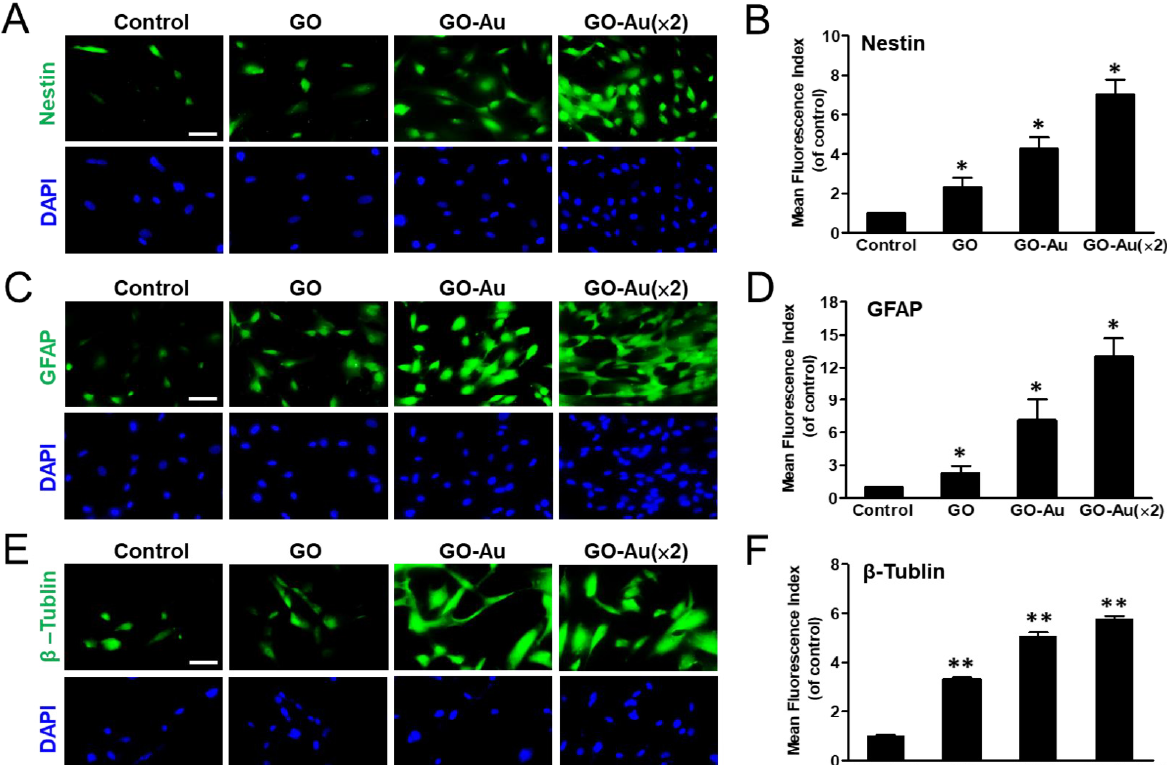
Figure 6. Characterization of GO-Au-mediated MSC differentiation into neuron cells. Cells were cultured on various nanomaterials of GO, GO-Au, and GO-Au ( × 2) for 7 days. Then, cells were analyzed for expression levels of ( A , B ) nestin, ( C , D ) GFAP and ( E , F ) β -tubulin, using an immunofluorescence assay. Scale bar, 20 μ m. The quantification of fluorescent intensity in nestin, GFAP, and β -tubulin protein expression. Data were presented as the mean ± SD, * p < 0.05 and ** p < 0.01.